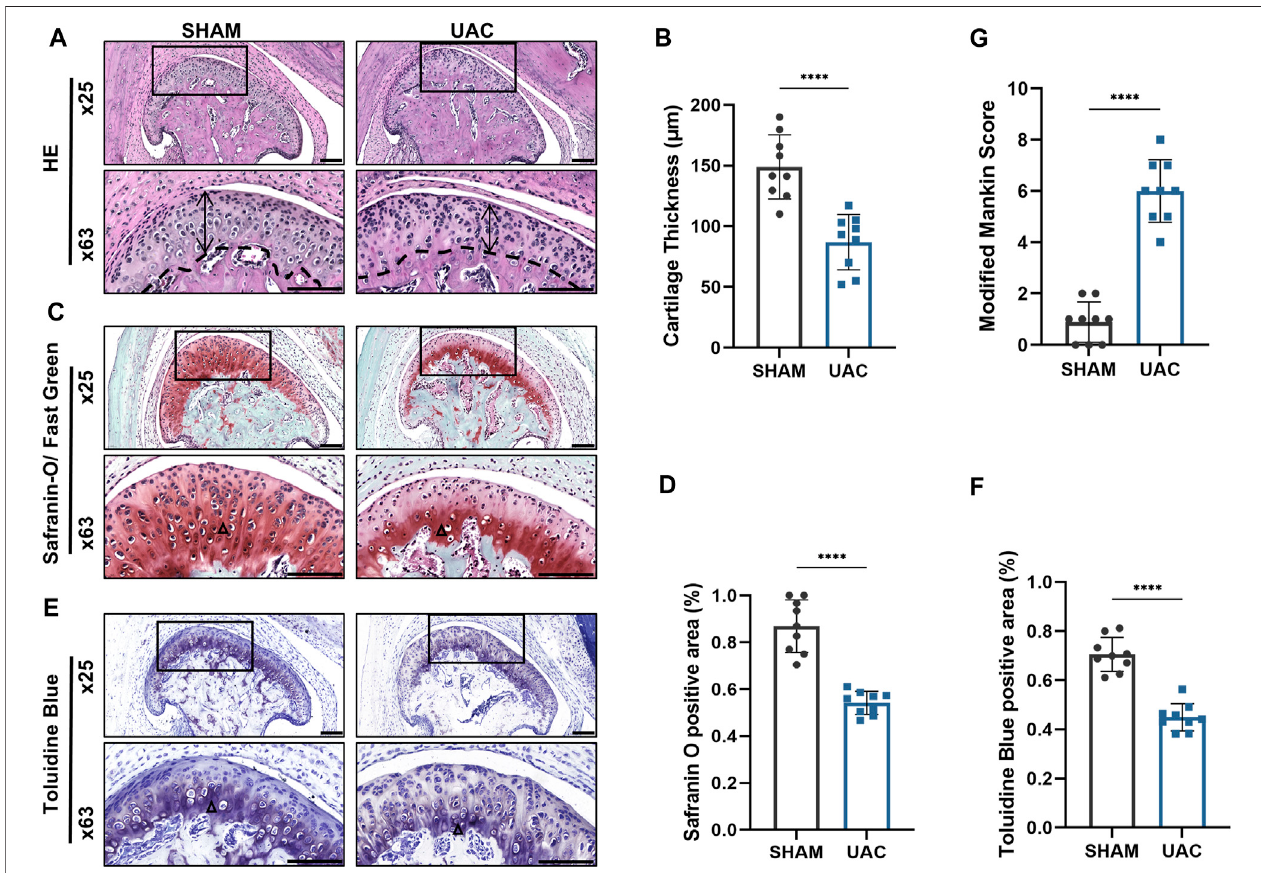
FIGURE1| Morphologicalchangesinthemousecondylarcartilageaftertheunilateralanteriorcrossbite(UAC)operation. (A,C,E) RepresentativesectionswithHE, Safranin-O/ Fast Green and Toluidine Blue staining of UAC and SHAM mice. Scale bar = 100 μ m. For visual comparison, condylar heads in (A,C,E) are adjusted to the same orientation. Double-head arrow indicates the cartilage thickness; black triangle represents staining positive area. (B) Comparison of average cartilage thickness ( μ m) between UAC and SHAM groups. n = 9/ group. (G) The modi fi ed Mankin scores of the cartilage in two groups. n = 9/ group. (D,F) The proportion of the safranin O and Toluidine Blue positive area to the entire cartilage layer in UAC and SHAM groups. n = 9/ group. (B,G,D,F) Data presented as Scatter dot plot with bar (mean ± SD). Signi fi cance was determined using t-tests. * p < 0.05; ** p < 0.01; *** p < 0.001; **** p < 0.0001.